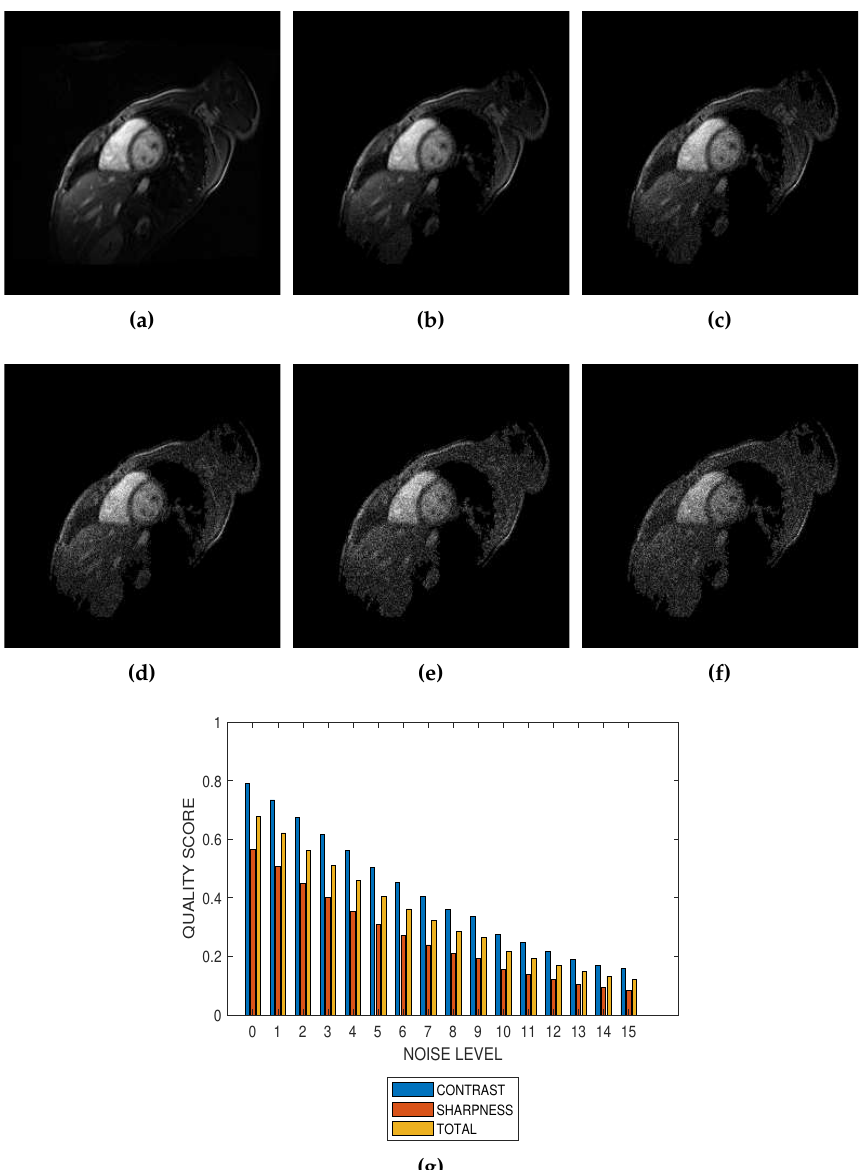
Figure 4. ( a ) A short axis cardiac MRI slice provided by the Department of Diagnostic Imaging of the Hospital for Sick Children in Toronto, Canada, and its degraded versions at Rician noise levels ( b ) 3 percent, ( c ) 6 percent, ( d ) 9 percent, ( e ) 12 percent and ( f ) 15 percent. ( g ) Variation of contrast, sharpness and total quality scores for Rician noise levels that vary from 0 percent to 15